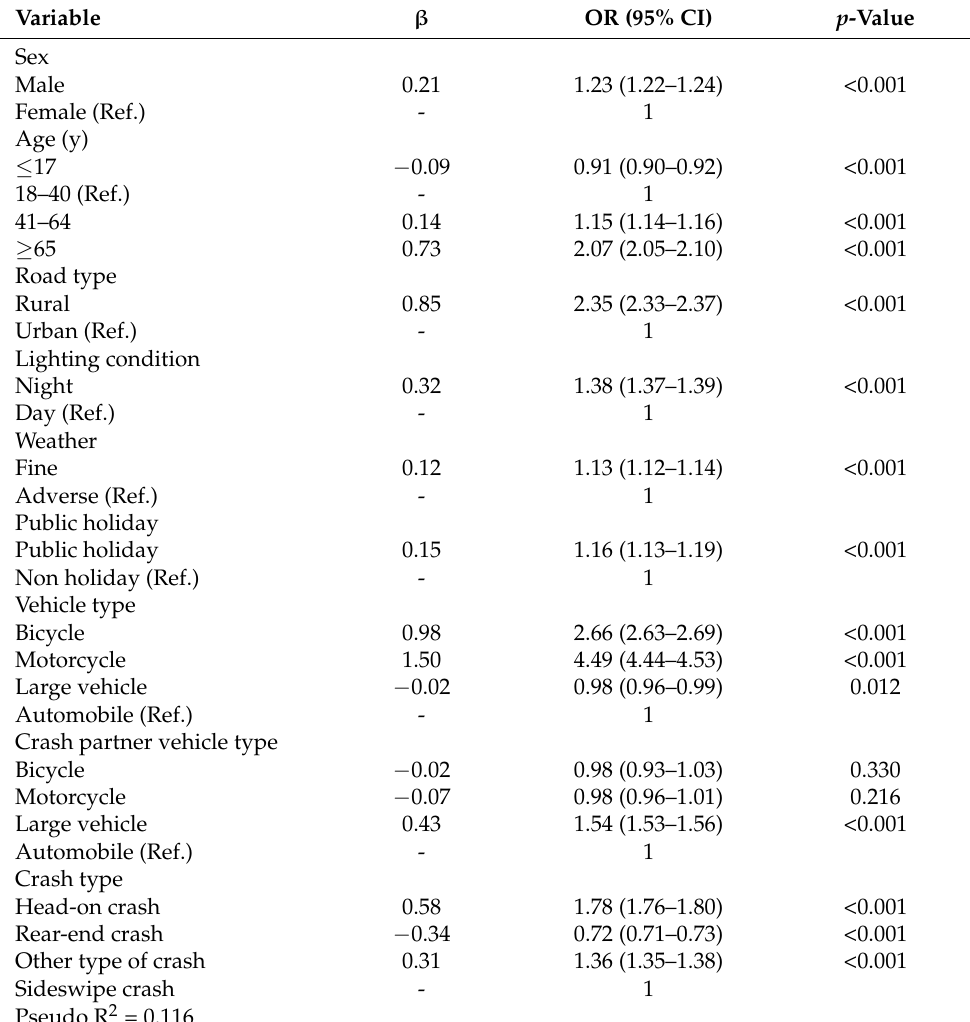
Table 4. Multiple logistic regression results of factors associated with KSIs (data based on UK STATS19 1990–2017)